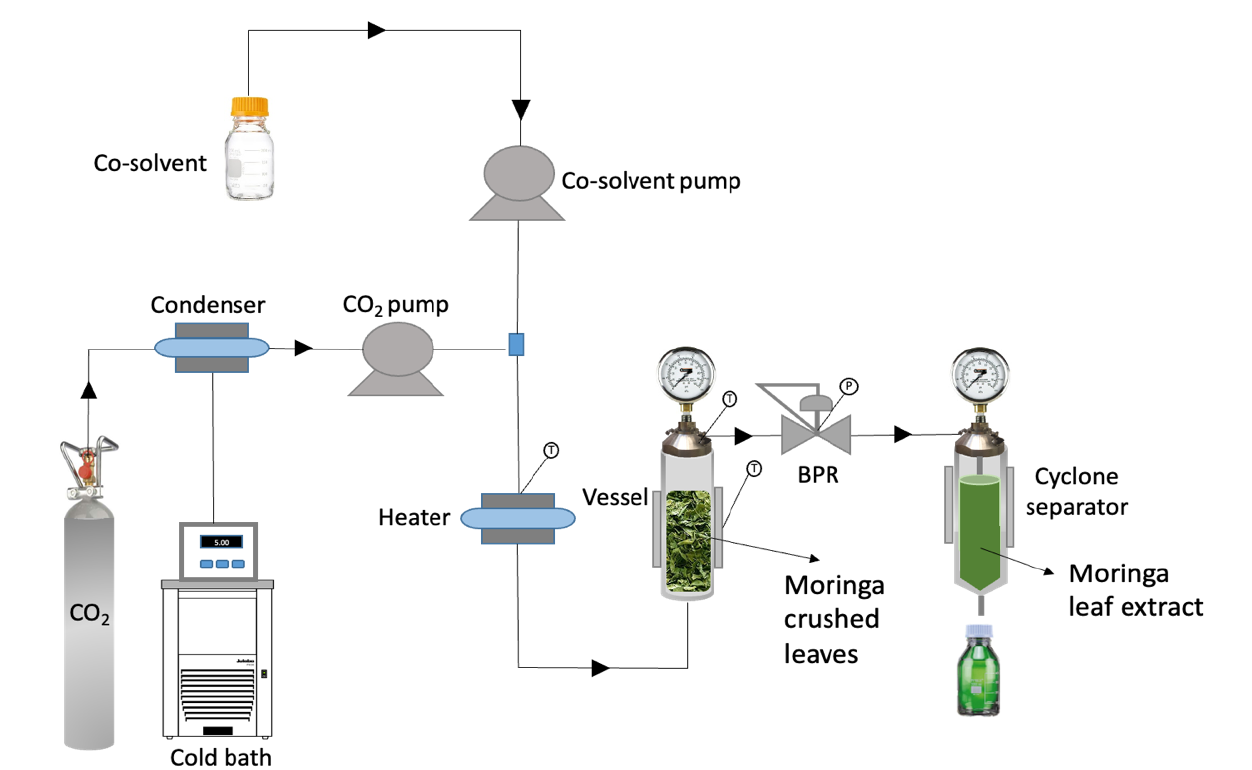
Figure 1. Diagram of the supercritical extraction equipment used.